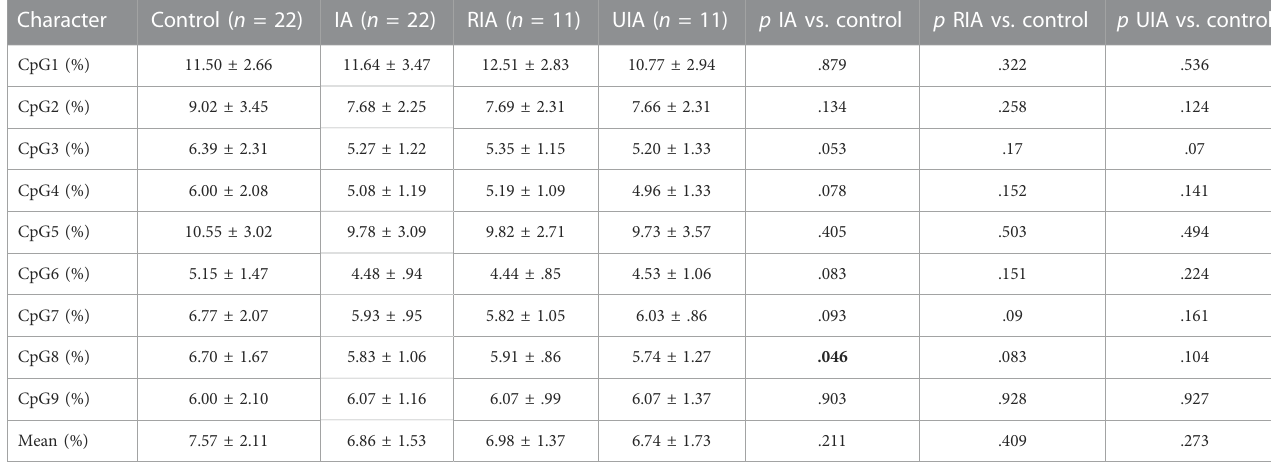
TABLE 4 DNA methylation differences of nine CpGs dinucleotides of GSTA4 gene between IA and control in men.